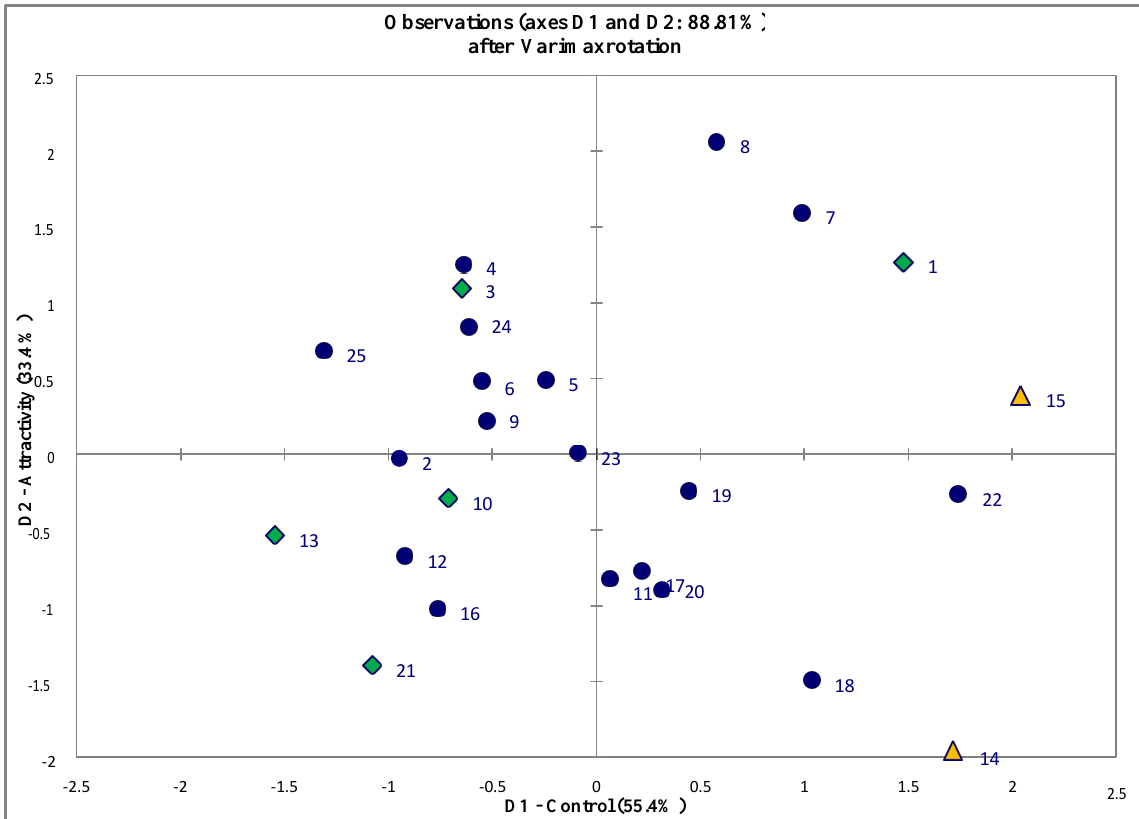
Legend: The yellow triangles mark the National Government and the Ministry of Health; the green diamonds signify the players focussed in the analysis; the blue circles represent the remaining players. For the numeric codes, see Table 3 in